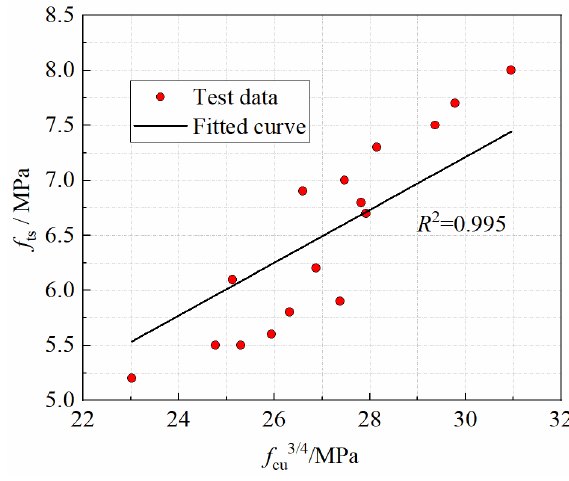
Figure 19. Relationship f ts vs. f cu3/4 .